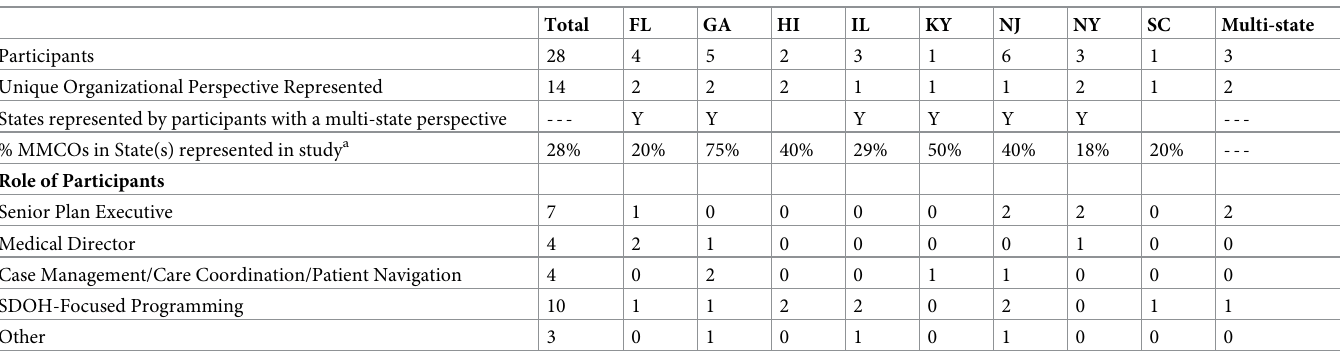
Table 1. Participating organizations by